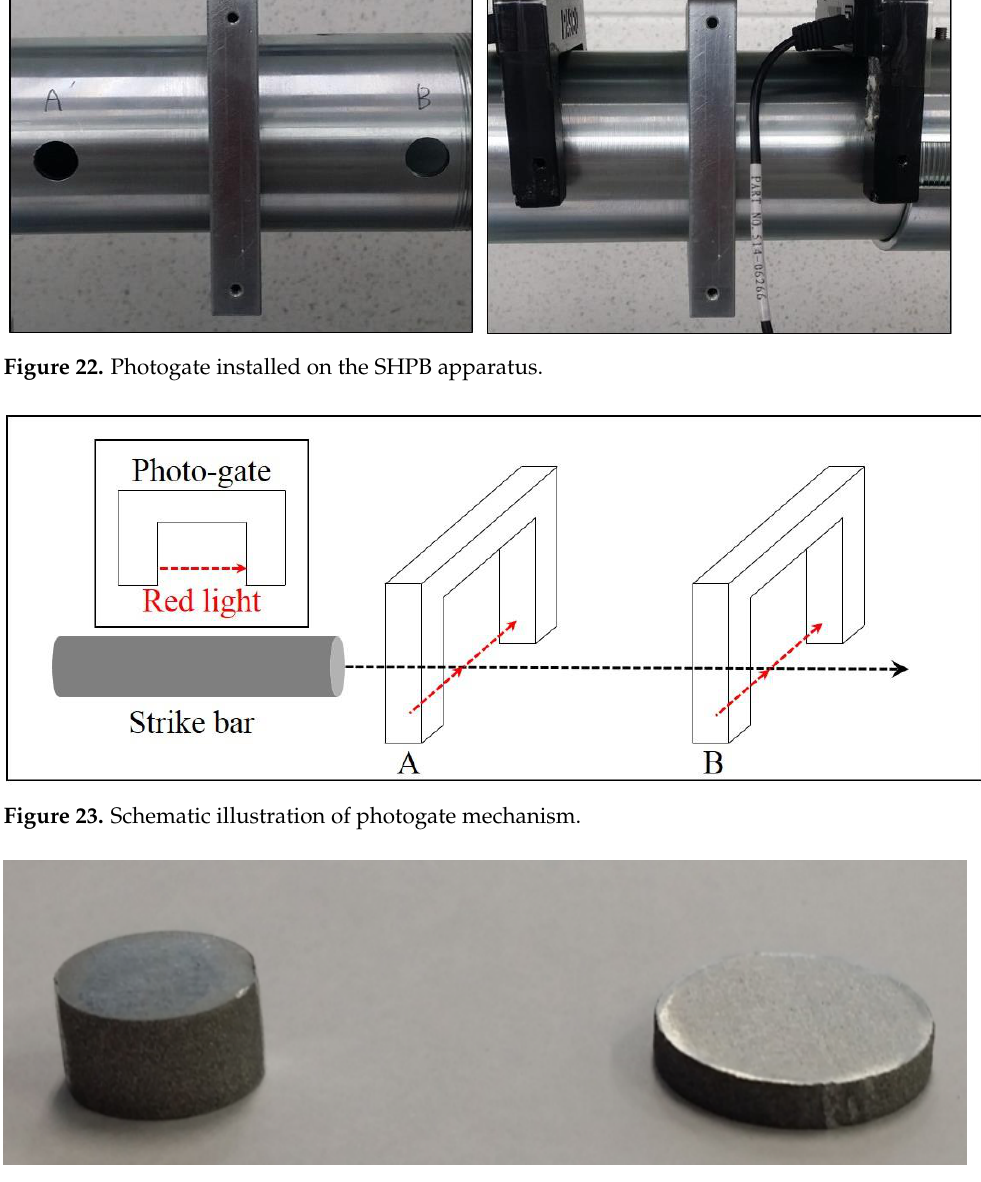
Figure 24. Test specimen used for the SHPB